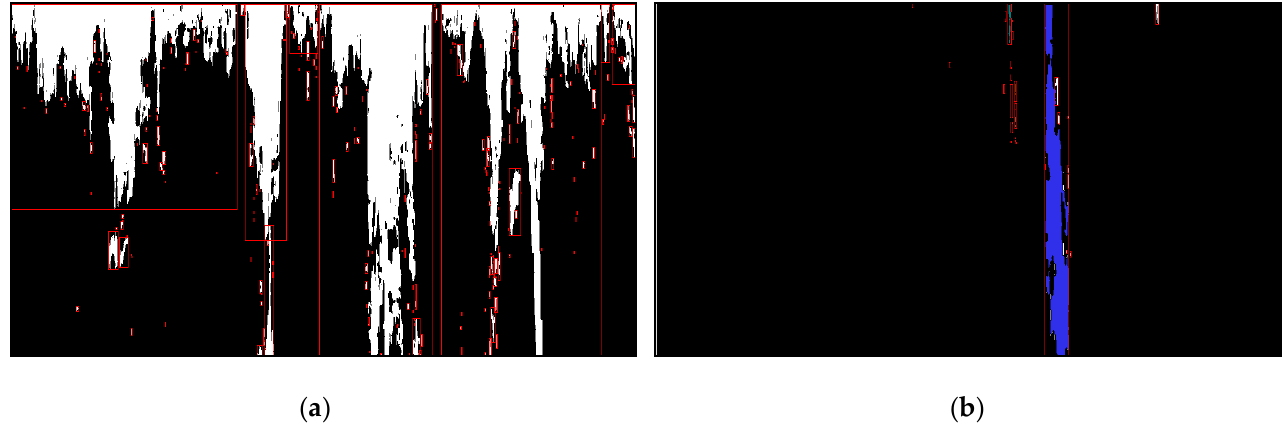
Figure 14. Comparison of recognition before and after hole wall image fusion. ( a ) Optical image recognition, ( b ) fusion hole wall image recognition.